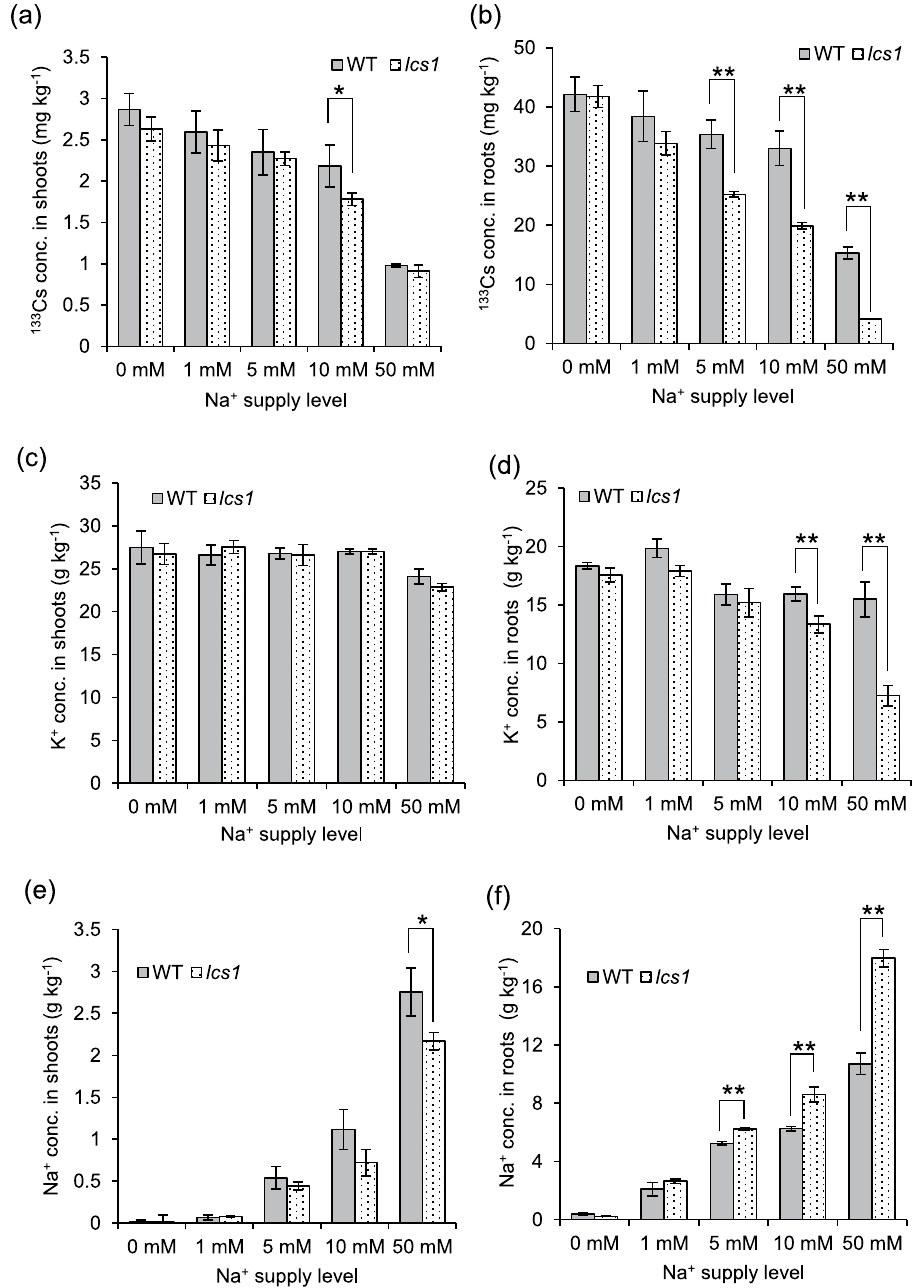
Figure 3. Effects of varying levels of Na + on the concentrations of stable 133 Cs, K + , and Na + in the shoots and roots of WT and lcs1 . ( a,b ) 133 Cs concentrations in ( a ) shoots and ( b ) roots. ( c,d ) K + concentrations in ( c ) shoots and ( d ) roots. ( e,f ) Na + concentrations in ( e ) shoots and ( f ) roots. Plants pre-cultured in 0.2 mM K + for 7 days were treated with nutrient solution containing 0.1 µ M Cs + and low K + (0.05 mM) at varying levels of Na + for 24 h. Data are means ± SD of three biological replicates. ** P < 0.01, * P < 0.05 ( t